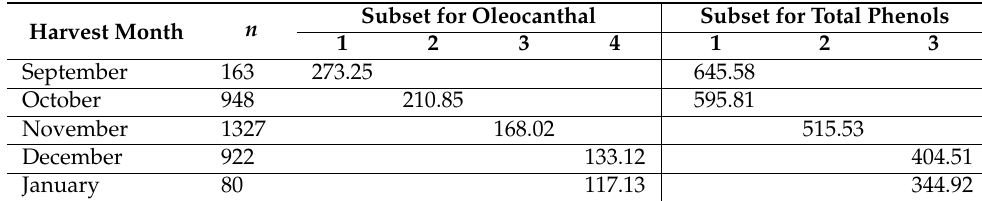
Table 2. Comparisons of oleocanthal means (mg/kg) and total phenols means (mg/kg) among harvest months using Duncan’s multiple range test ( a = 0.05) (harvest months reside in the same subset are not statistically